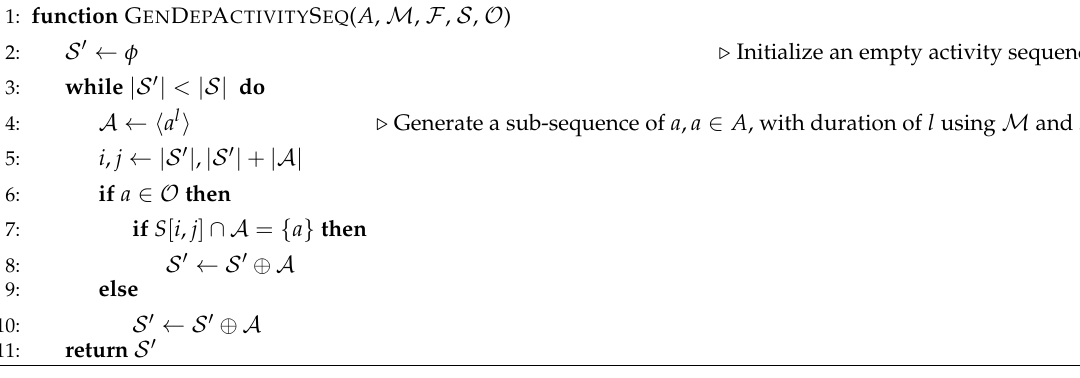
Algorithm 2 Generate a dependent activity sequence with the condition (7).